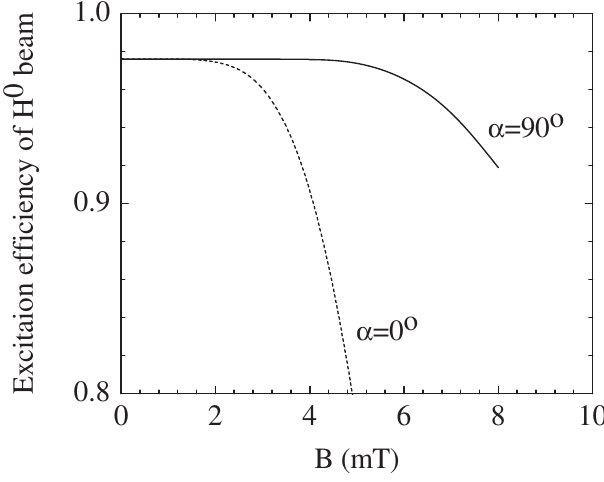
FIG. 1. Excitation efficiency as a function of magnetic field B for two types